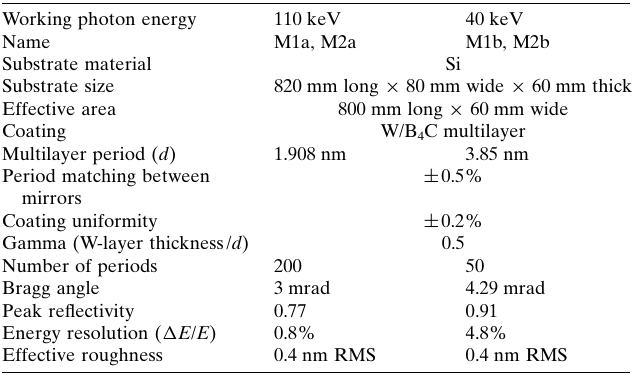
Table 1 Design parameters of the multilayer mirrors.